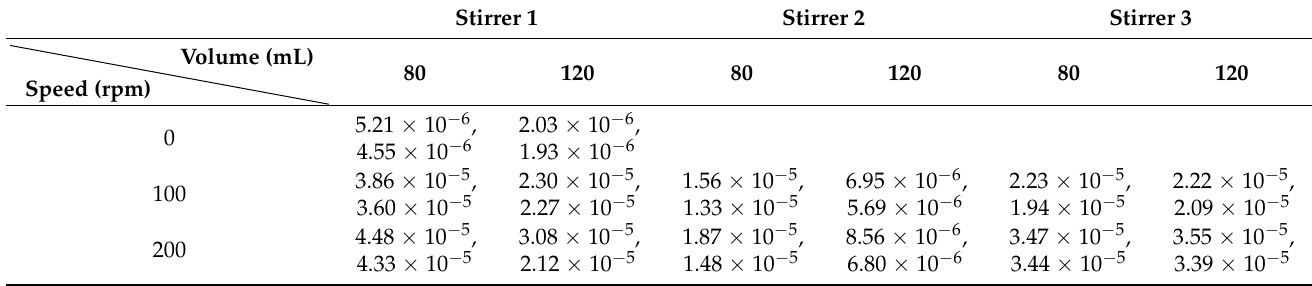
Table 1. Mass-transfer coefficients (m s − 1 ) for 0.3 g benzoic acid tablets dissolved in deionized water (beaker and stirrer system).